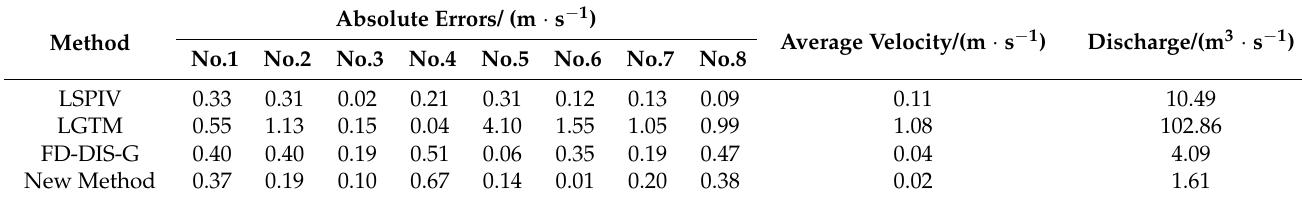
Table 6. Absolute errors of the vertical line average velocity of four methods.